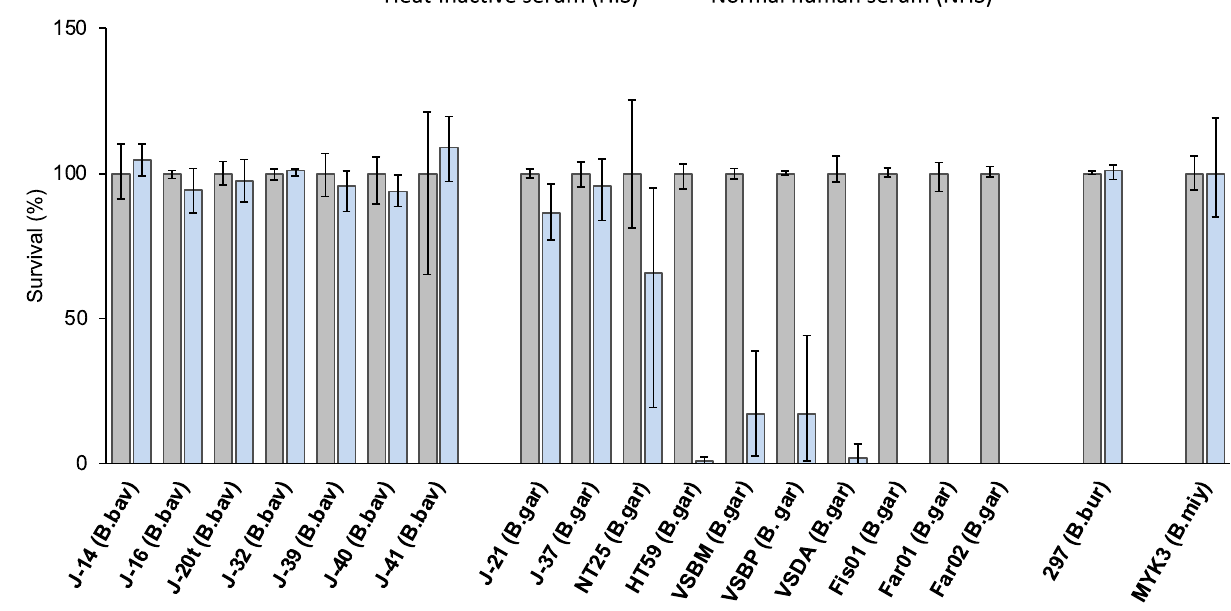
Figure 1. Serum susceptibility of Borrelia strains used in this study. Spirochetes were incubated in either 40% normal human serum (NHS) or heat-inactivated serum (HIS) for 5 days at 37 °C. Cell viability was assessed using microscopic counts of cells in 10 fields under ×300 magnification. The figure depicts the means, and error bars represent the positive and negative errors of the mean of triplicates from one representative experiment. Borrelia species names abbreviated as follows: Borrelia bavariensis (B. bav), B. garinii (B. gar), B. burgdorferi , (B. bur), and B. miyamotoi (B.